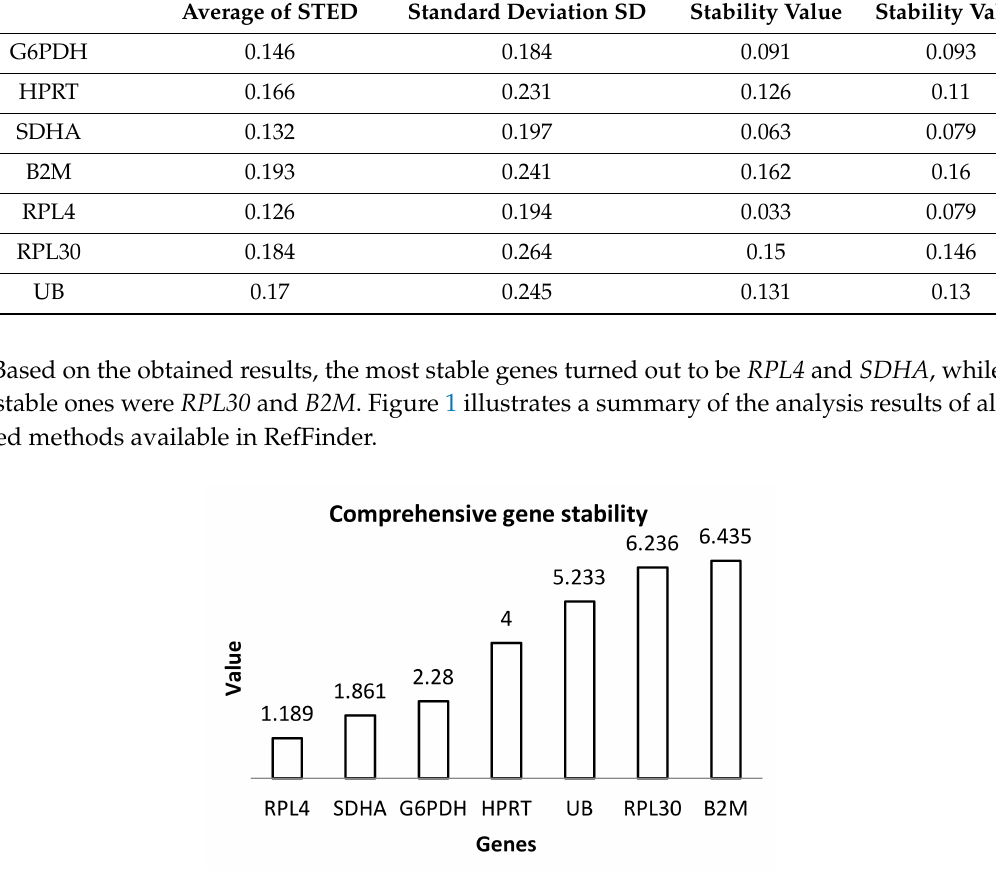
Table 2. Results of reference genes analysis—Delta Ct, BestKeeper, NormFinder and geNorm. Reference Gene